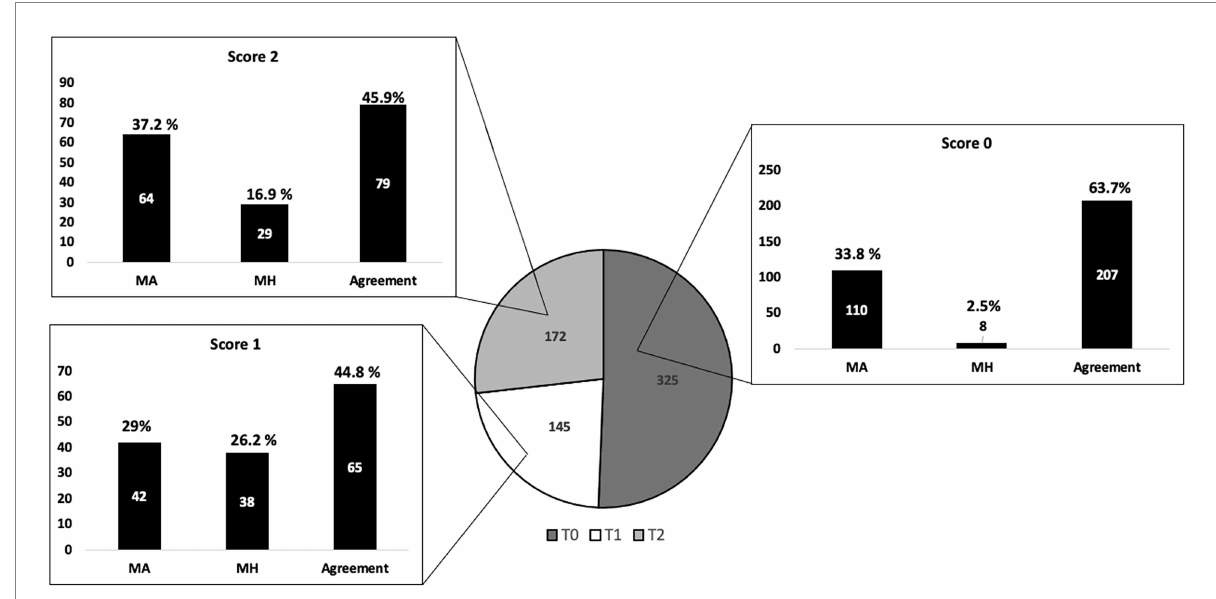
FIGURE 8 Agreement and types of misscores across machine approaches by score category for item